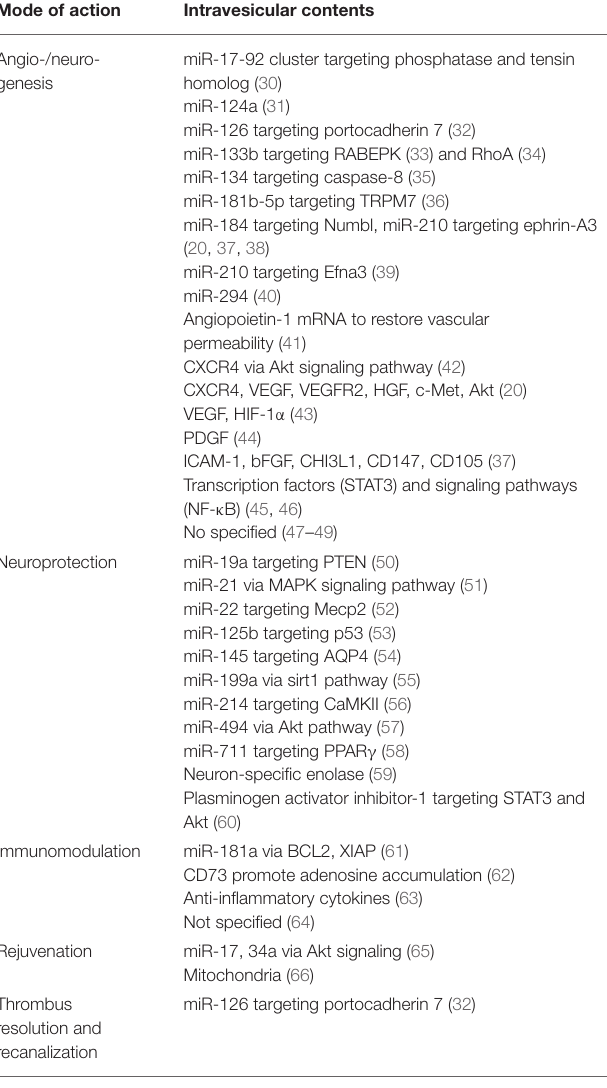
TABLE 1 | Mode of action of stem cell-derived EV in animal models of stroke or other ischemic disease. Mode of